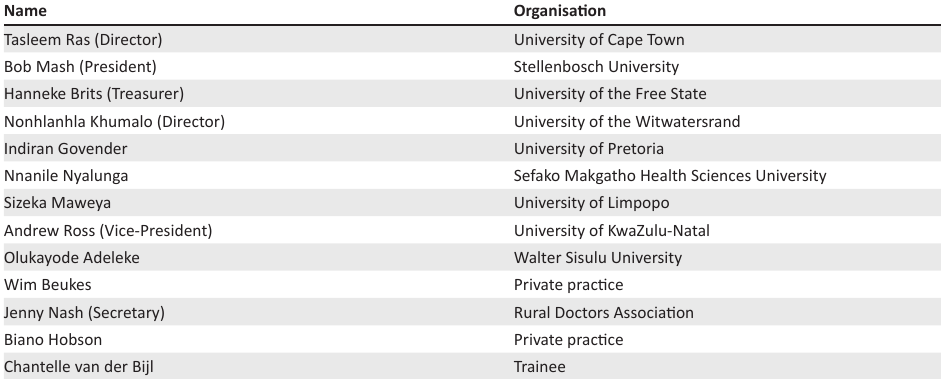
TABLE 1: The Academy Council